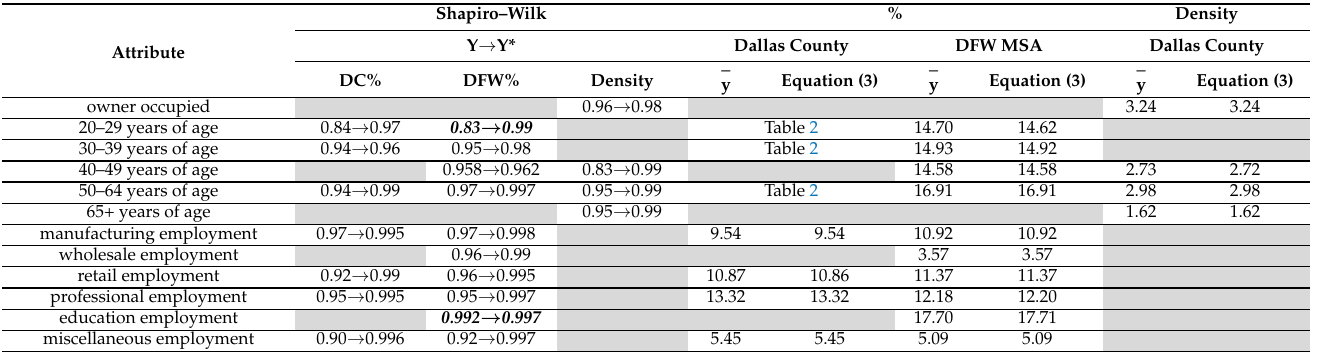
Table 4. Selected Manly transformed 2010% and density attribute variables experiencing improve- ment in their individual correspondences with a Gaussian probability density